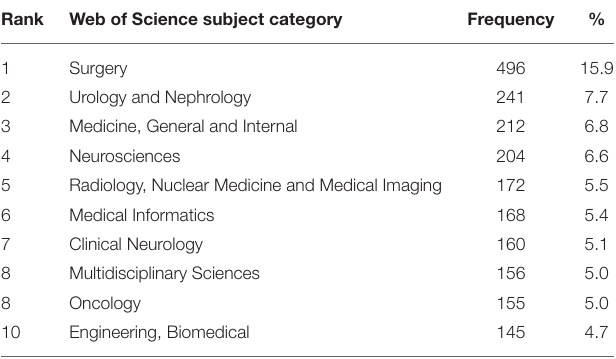
TABLE 4 | The most productive Web of Science subject categories in gender-related articles in medical artificial intelligence.